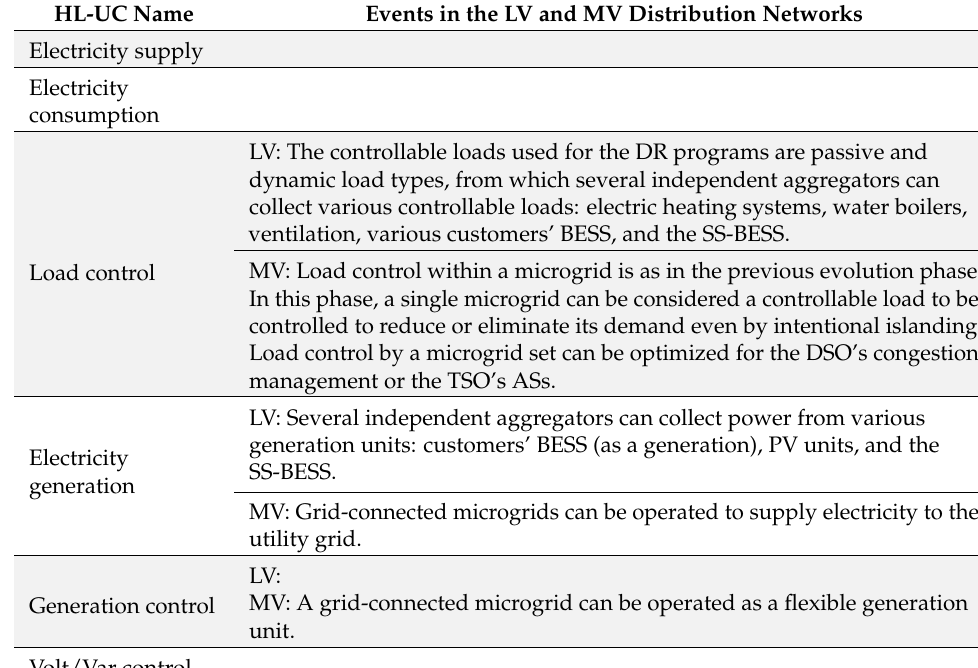
Table 5. Energy management high-level use cases in the intelligent microgrid network